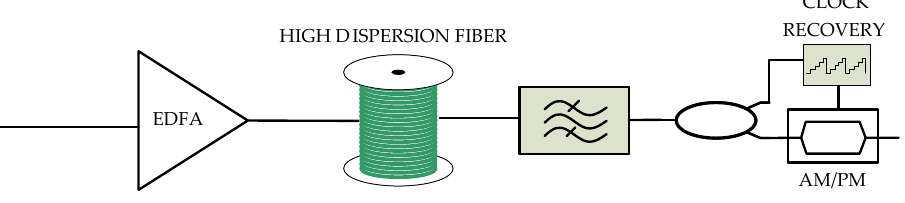
Figure 4. Principle of synchronous modulation optical